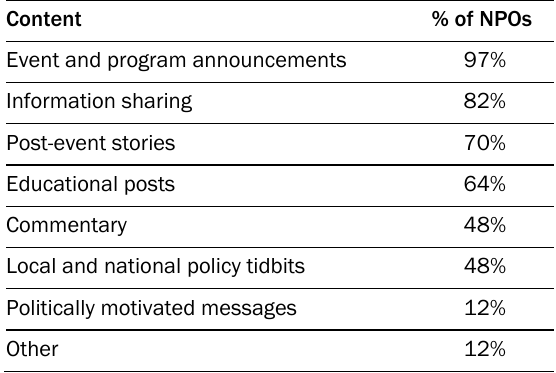
Table 4. Types of Content People